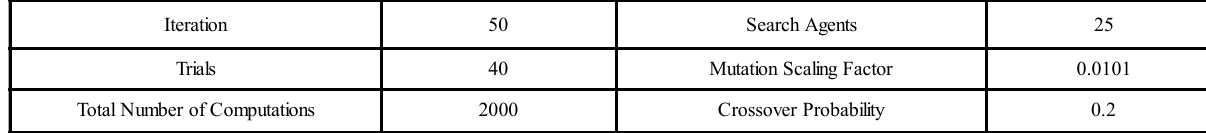
TABLE 1. LIST OF PARAMETERS TAKEN FOR TEST SYSTEM-I